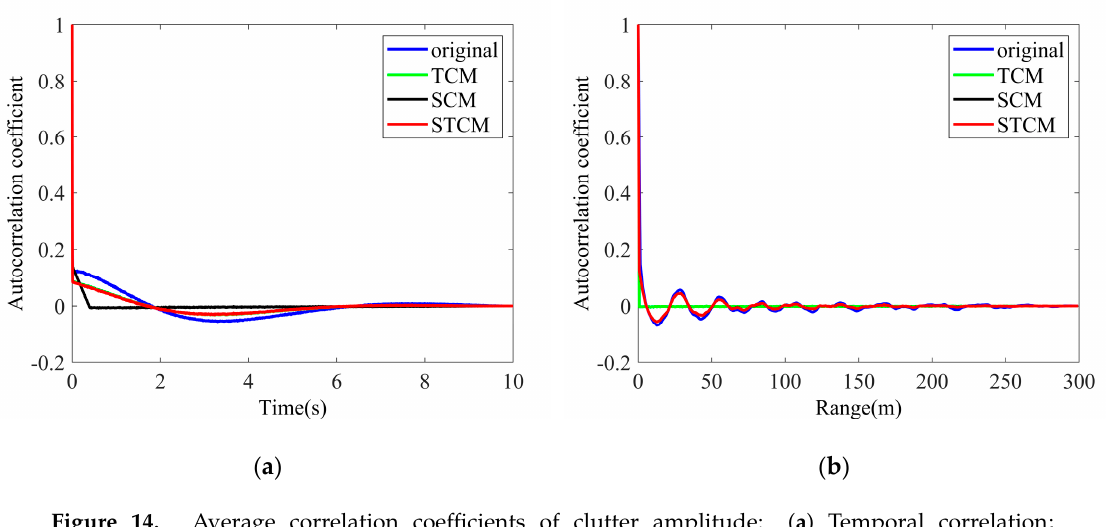
Figure 14. Average correlation coefficients of clutter amplitude: ( a ) Temporal correlation; ( b ) Spatial correlation.